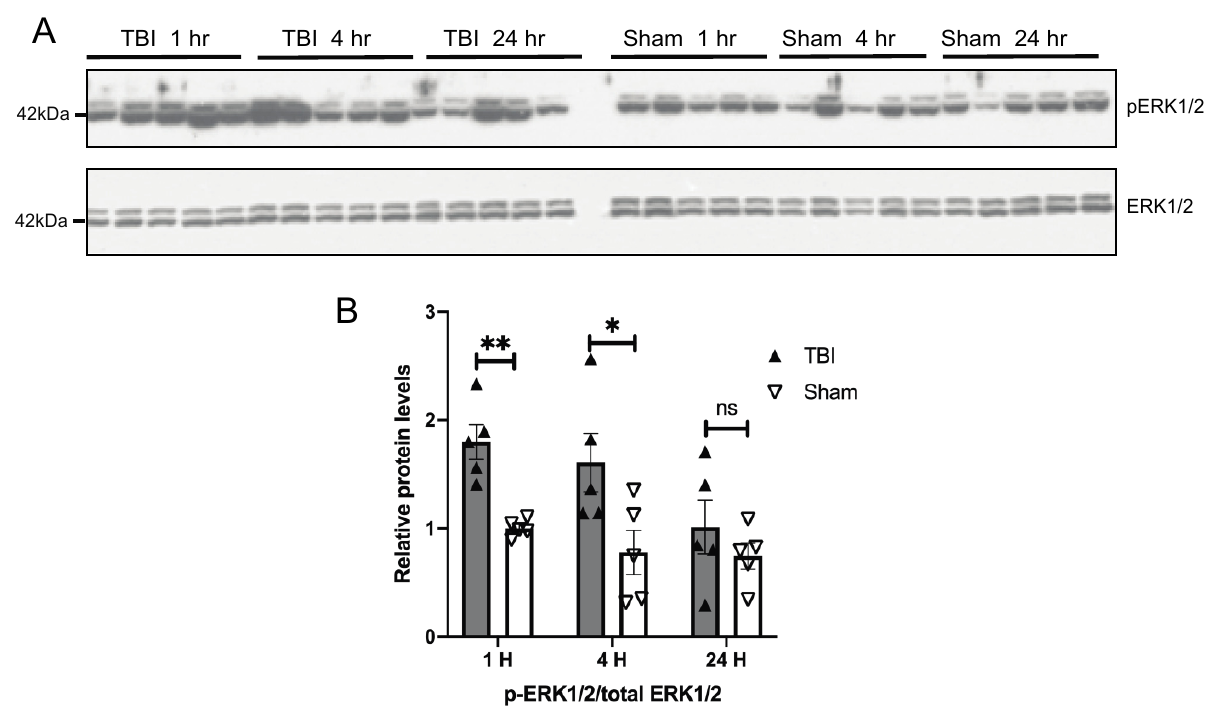
Figure 5. BOP caused the activation of c-Jun N-terminal kinase (JNK) in the mouse brain. Representative Western blots ( A ) and quantification analysis ( B ) revealed the activation of JNK after blast ( n = 5/group). (Data are means ± SEM, *** p < 0.001; ns, non-significant). pJNK: phospho-JNK.